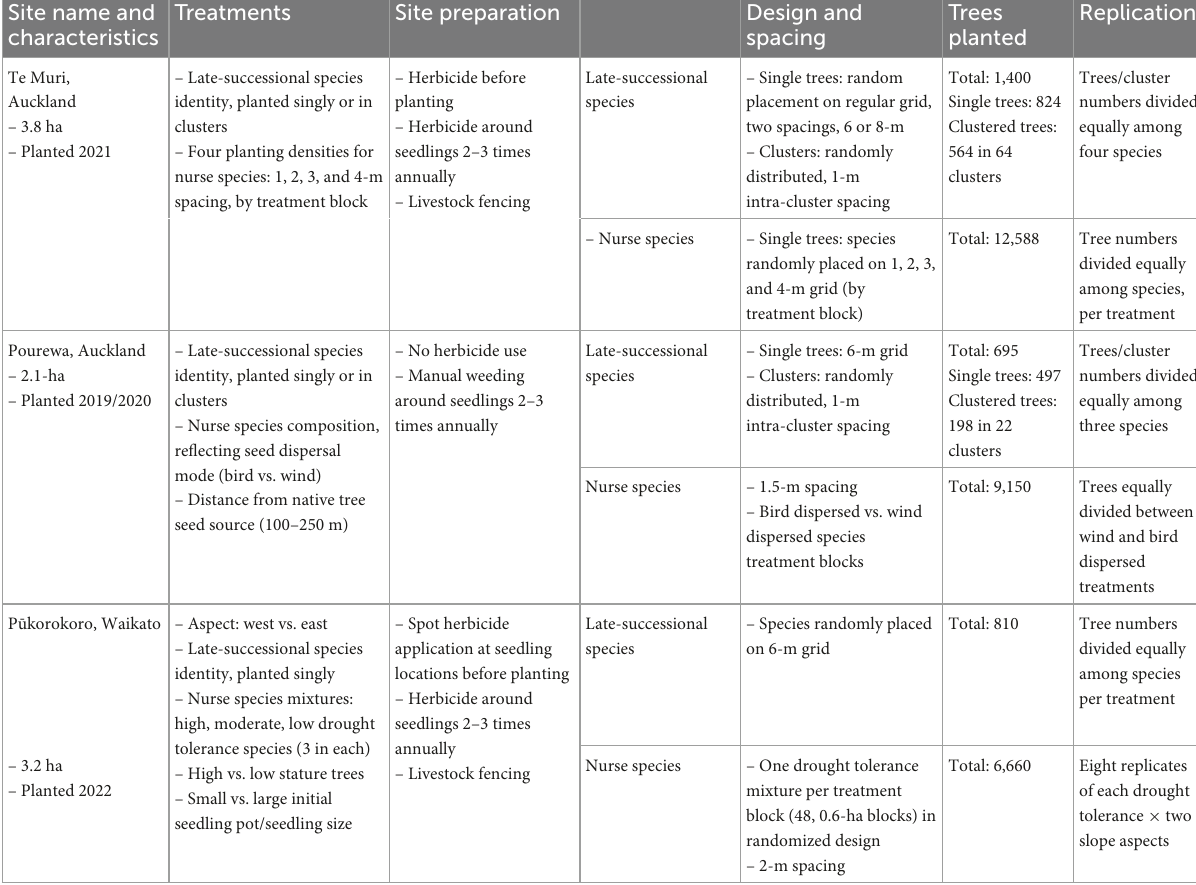
TABLE 1 Experimental set up information for three AUT Living Laboratories